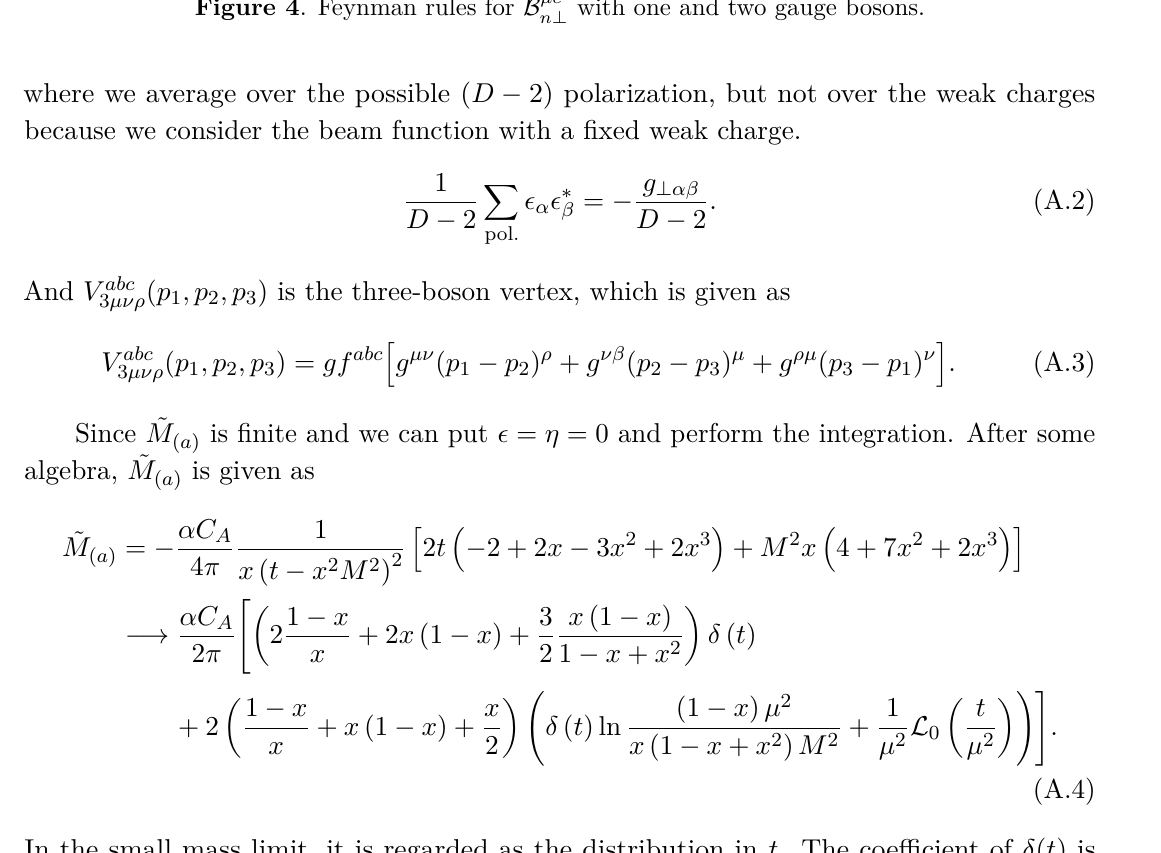
Figure 4 . Feynman rules for B µc